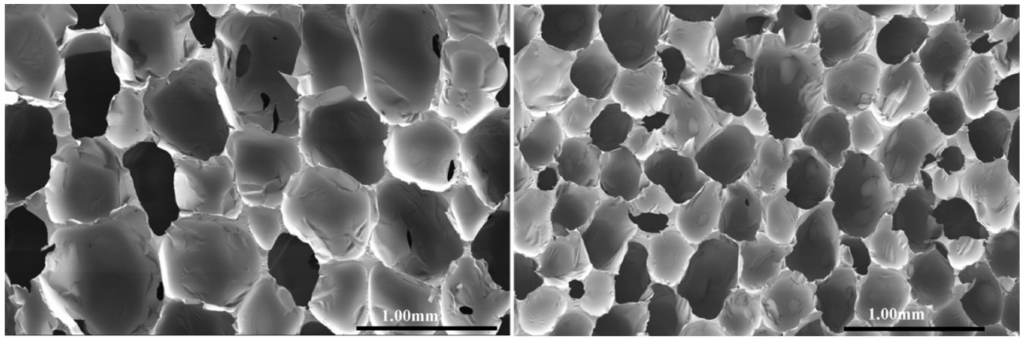
Figure 5. SEM micrographs of PU-DZS ( left ) and PU-DZS-TPP 25 ( right ).